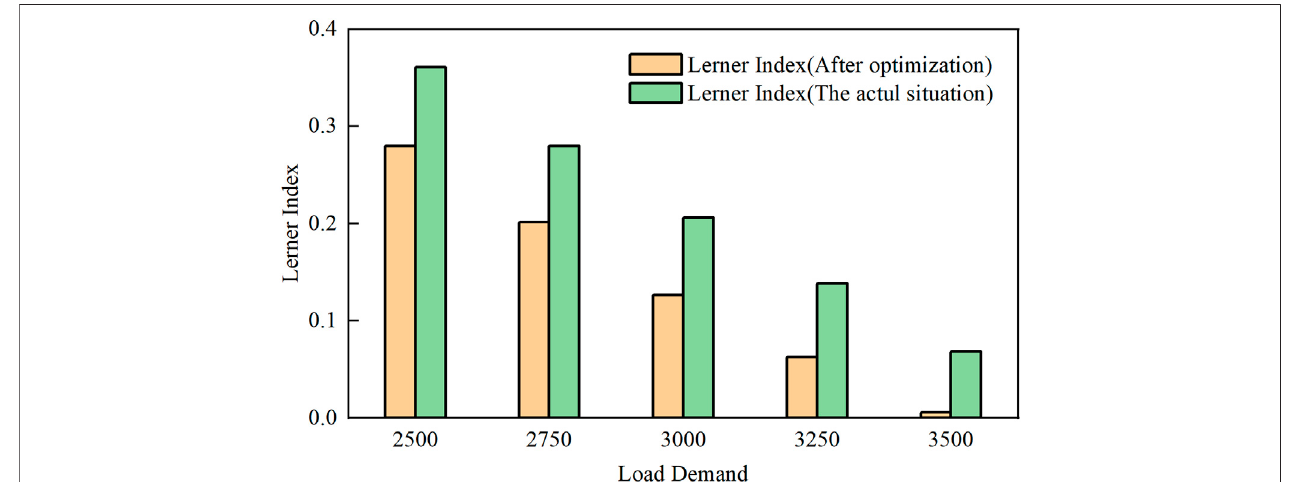
FIGURE 4 | The Lerner Index of electricity market in actual situation and after optimization.